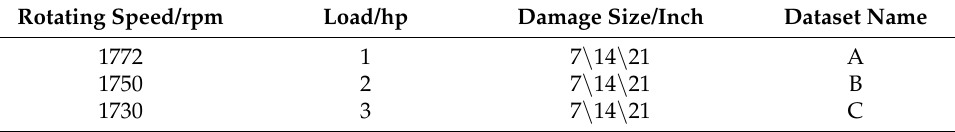
Table 4. Bearing working